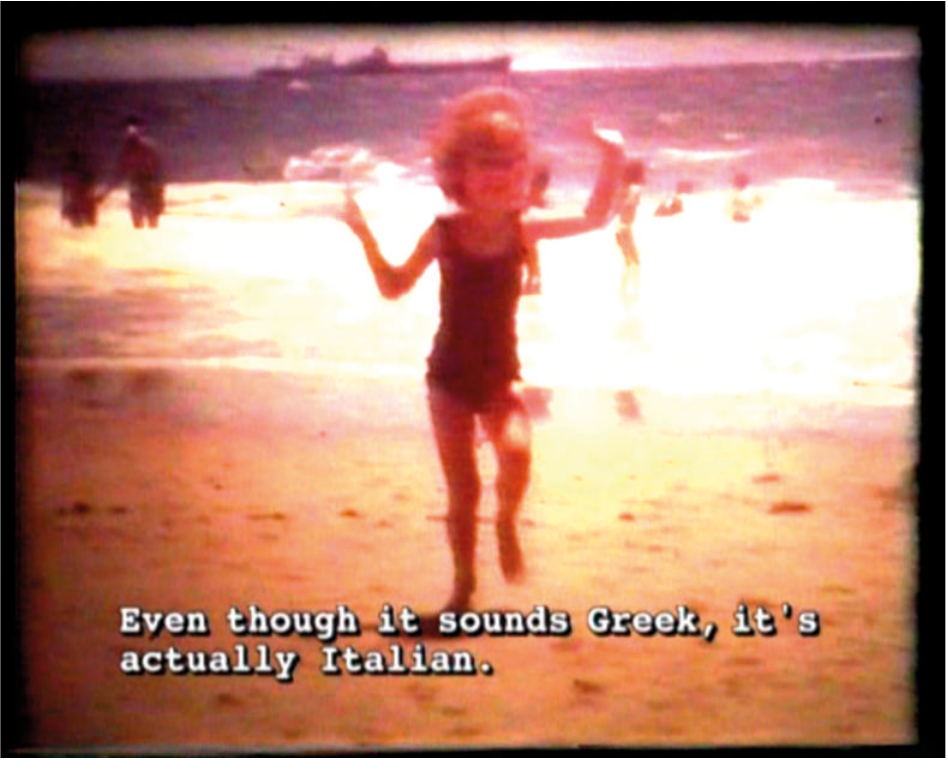
Penny Siopis, My Lovely Day (film still), 3rd ed., 1997. Video installation of mini cinema and 8mm film transferred to video, 21 minutes. Museum of Modern Art, Stockholm; South African National Gallery, Cape Town; the artist (photo: courtesy Penny Siopis and Stevenson Gallery, Cape